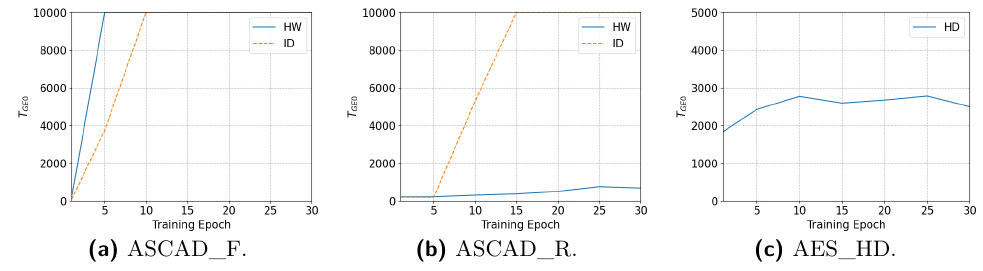
Figure 9: The effect of training epoch.